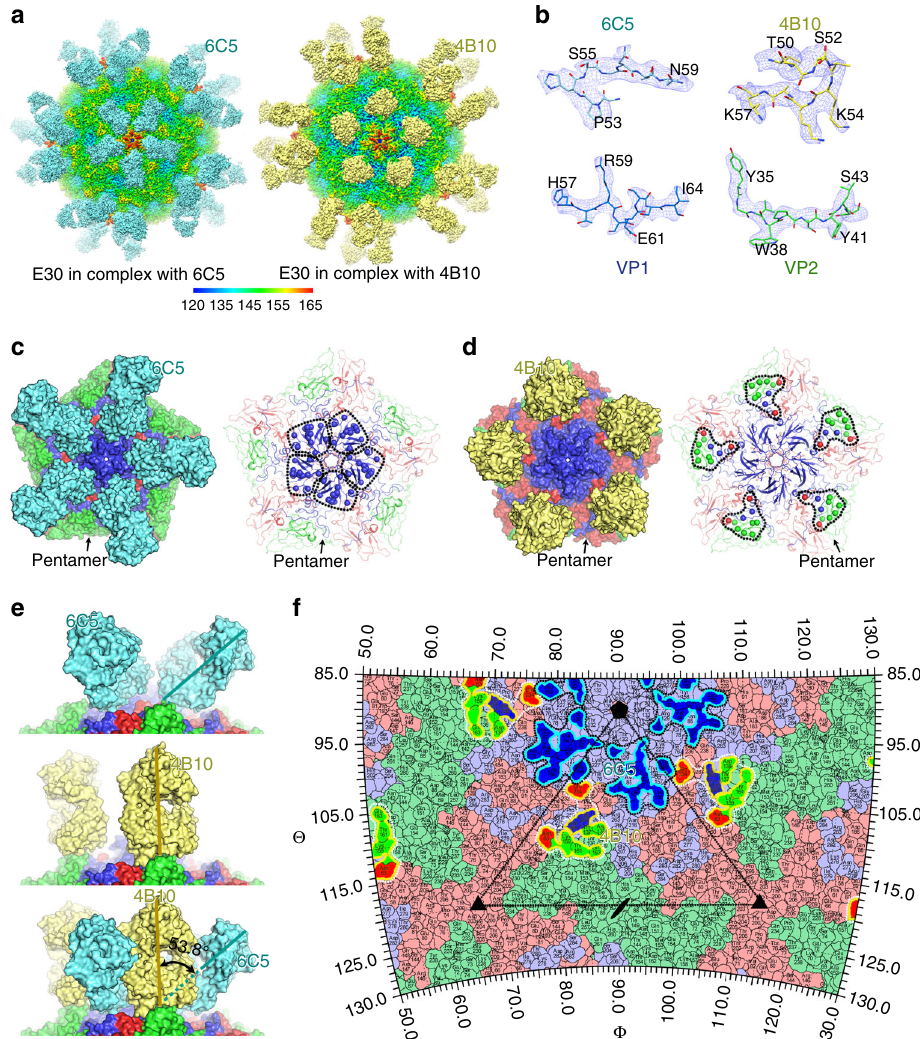
Fig. 3 Cryo-EM structures of E30 in complex with 6C5 Fab or 4B10 Fab. a Surface representations of E30-6C5-complex (left) and E30-4B10-complex (right). The viral parts of both complexes are rainbow-colored as the color bar below shows; the 6C5 Fab and 4B10 Fab are colored in cyan and yellow, respectively. b Electron density maps for representative sections of VP1 and 6C5 (left) from E30-6C5-complex, and sections of VP2 and 4B10 (right) from E30-4B10-complex. c , d Fab occupancy (left) and epitopes (right) of 6C5 (c) and 4B10 (d) on a viral pentamer. The pentamers are shown as surface (left) or cartoon (right) in the signature colors (VP1, blue; VP2, green; VP3, red), while Fabs are colored in the same scheme as in 3a. The epitopes of 6C5 (left in 3c) and 4B10 (right in 3d) are shown as spheres and those from one protomeric unit are circled by black dotted lines. e Side views of two Fabs bound to a pentamer. The same color scheme is applied as above. When the E30-6C5 (top) and E30-4B10 (middle) are superposed, the complex (bottom) generated shows an angle of 53.8° between 6C5 and 4B10. f Footprints of 6C5 and 4B10 on the sterographic projection of E30. Residues of VP1, VP2 and VP3 are colored in pale blue, pale green and pale red, respectively; residues involved in binding with 6C5 and 4B10 are shown in brighter colors corresponding to the protein subunit they belong to. The footprints of 6C5 and 4B10 on each protomeric unit are outlined in cyan and yellow, respectively, and circled in black and white dotted lines, respectively. One icosahedral asymmetric unit with fi ve-, three- and twofold icosahedral symmetry axes are marked